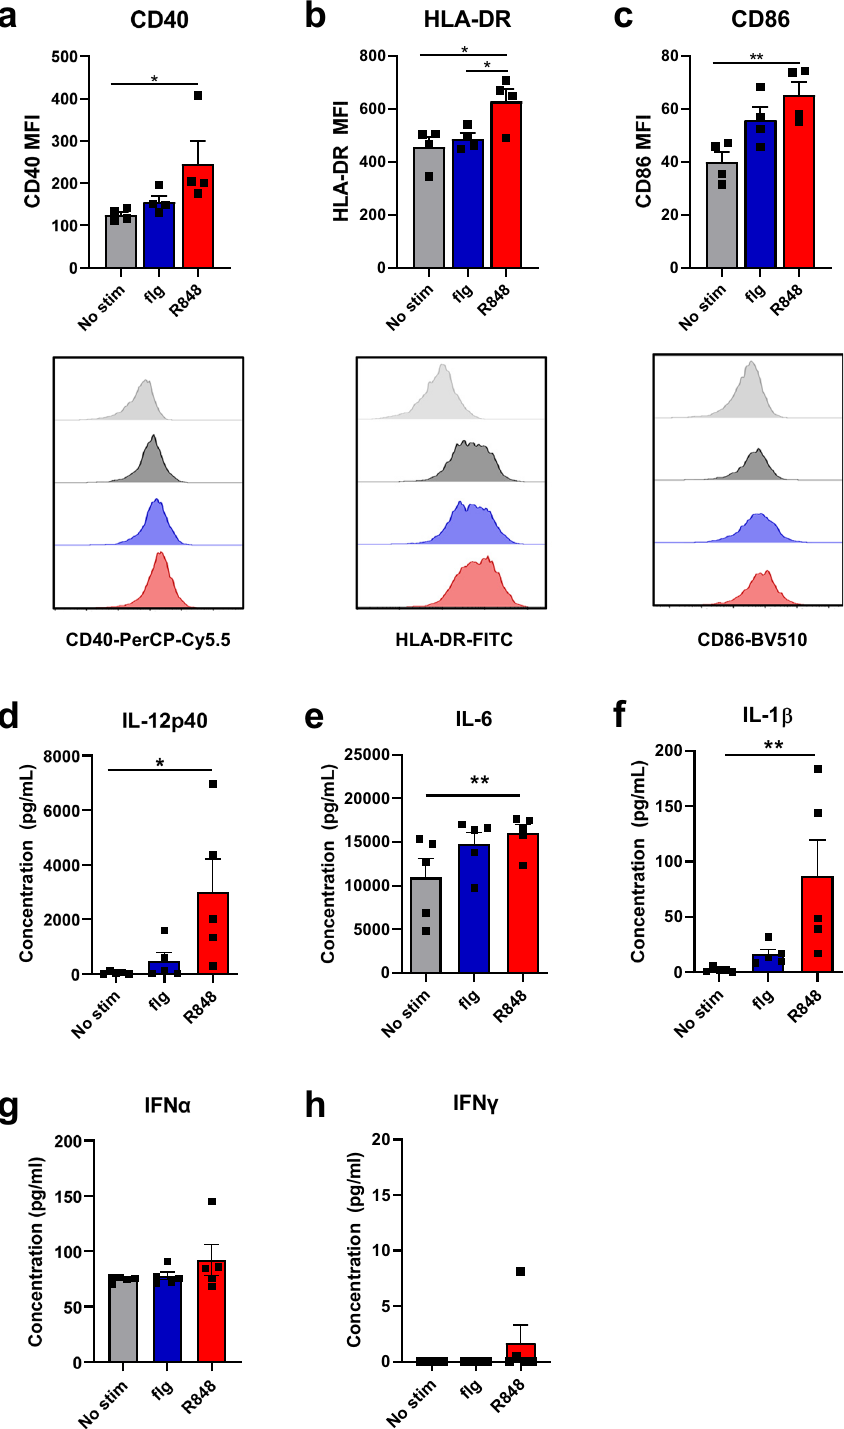
Fig. 5 R848 induces robust activation of newborn BMDC. DC were differentiated from bone marrow obtained from naïve newborn AGM using hIL-4 and hGM-CSF. On day 6 of culture, cells were stimulated with R848, fl agellin, or PBS for 24 h. CD11c + positive cells were assessed for surface expression of CD40 ( a ), HLA-DR ( b ), and CD86 ( c ). Average median fl uorescent intensity is shown with representative histograms below. Supernatants were harvested from fl agellin or R848 stimulated BMDC cultures at 24 h. IL-12p40 ( d ), IFN α ( g ), and IFN γ ( h ) levels were assessed by ELISA. IL-6 ( e ) and IL-1 β ( f ) were quanti fi ed by cytokine bead array. Statistical signi fi cance was determined using a Friedman test with uncorrected Dunn ’ s test for multiple comparisons. * p < 0.05, ** p <